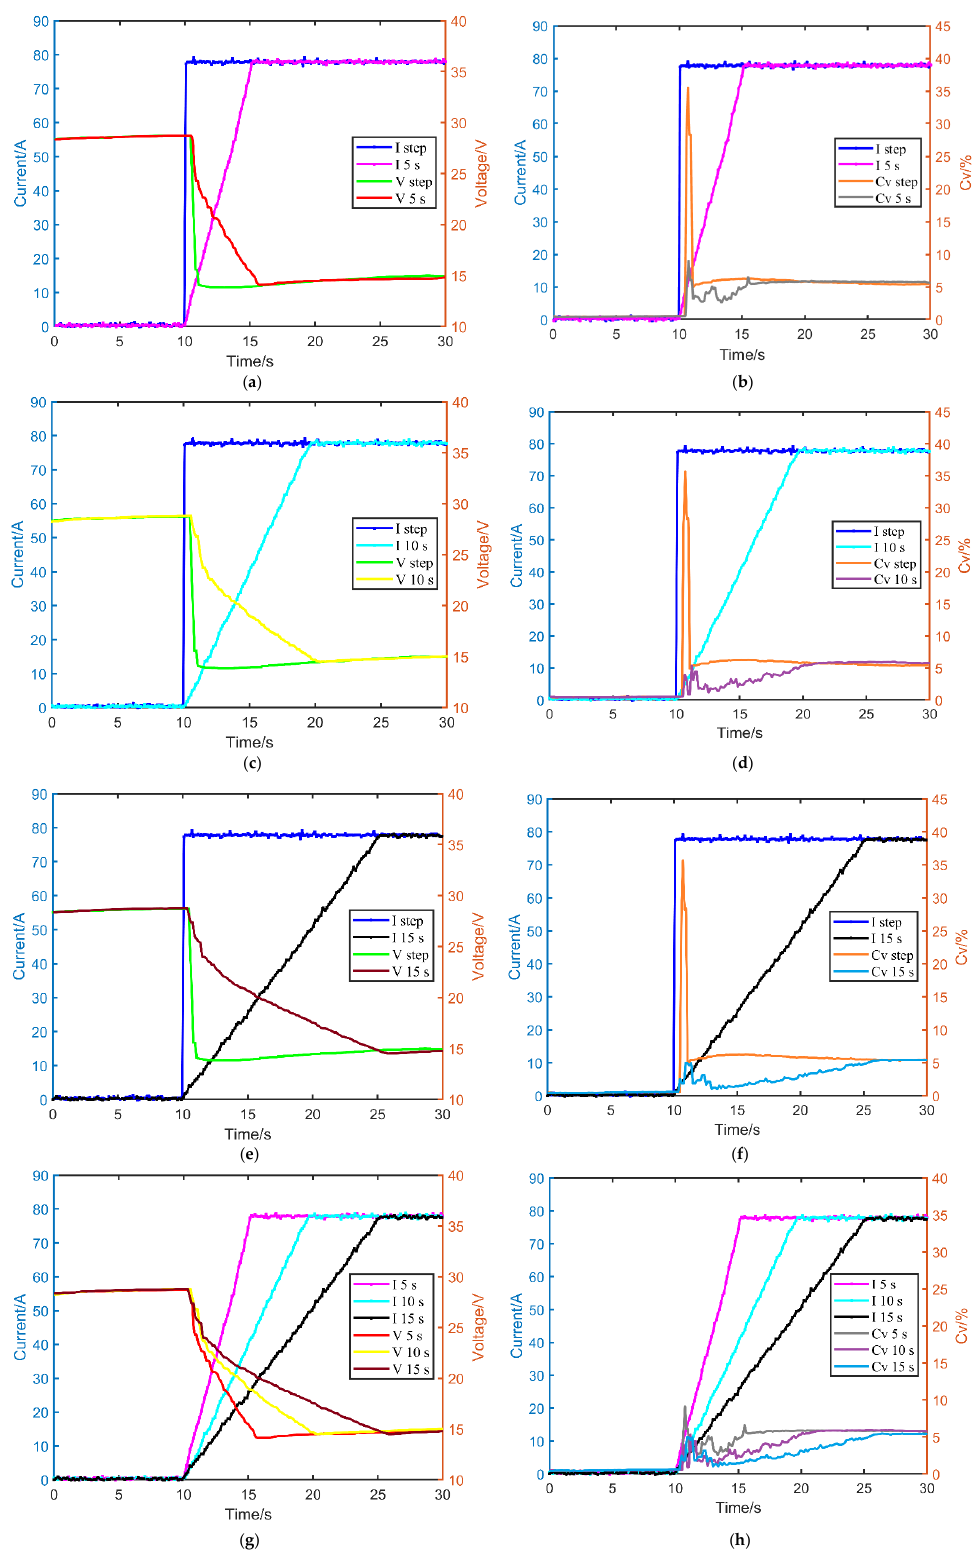
Figure 7. Comparison of output characteristics among step loading and constant rate strategies with loading times of 5, 10, and 15 s. ( a , c , e , g ) present exerting current and stack voltage; ( b , d , f , h ) present exerting current and Cv values.